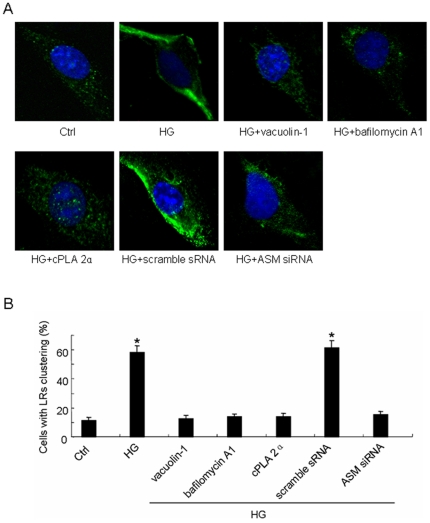
The effect of HG incubation on lipid rafts (LRs) clustering and the manifestations after inhibition of lysosome-membrane fusion.A: Representative images of LRs clustering in cell incubated by normal glucose (Ctrl) or high glucose for 12 h (HG) with or without the pretreatment by vacuolin-1(10 µmol/l), bafilomycin A1 (100 nmol/l), cPLA 2α (20 µmol/l) for 1 h, or after scramble sRNA or ASM siRNA transfection. B: summarized results on percentage of cells with LRs clusters in different groups. Values are means±SE; n = 5 batches of cells. * P<0.05 vs. Ctrl.